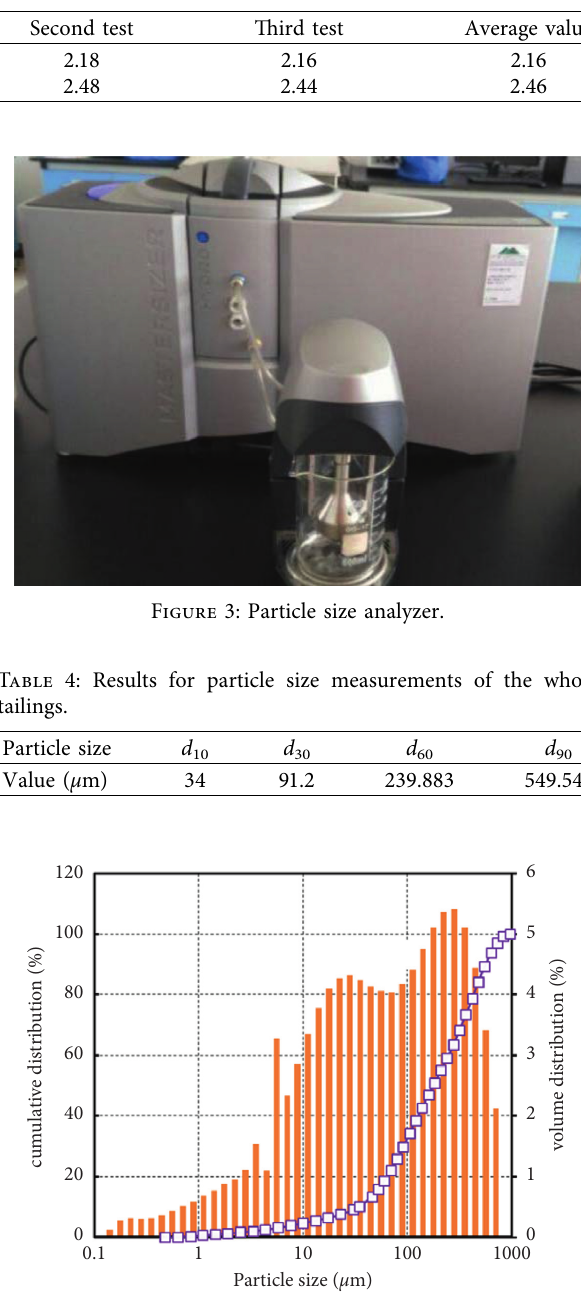
Table 2: Test results of bulk density of the whole tailings.